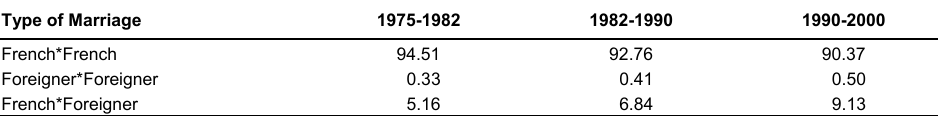
Types of marriages celebrated in France between 1975-2000 Type of